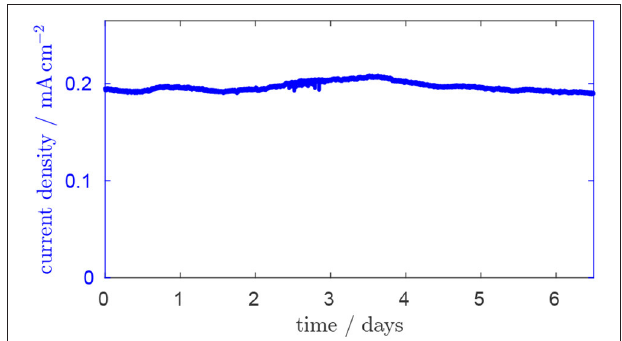
FIGURE 2 | Current over time after chemostatic conditions are established. Residence time is 28.8h, glycerol inlet concentration 1.8mM, anode potential